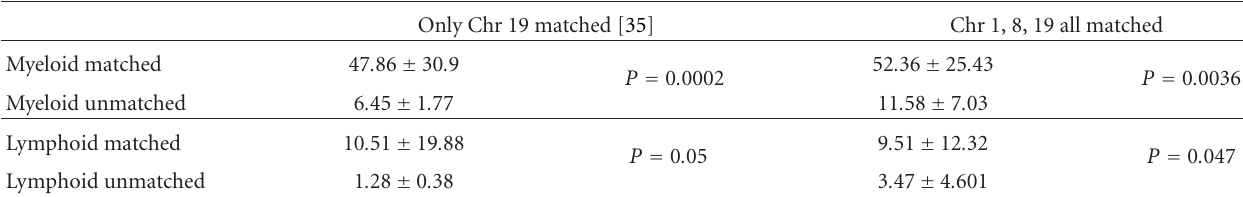
Table 1: Mean percentage of GFP + cells in engrafted recipient zebrafish receiving MHC-matched or -unmatched donor